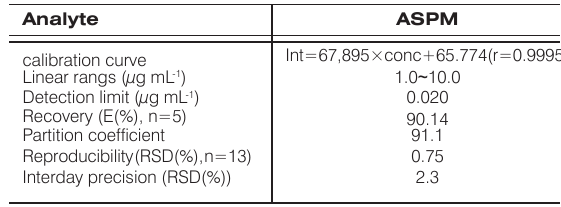
Table 2. The parameters of ASPM by ILATPS and molecular fluorescence spectrophotometer Analyte ASPM calibration curve